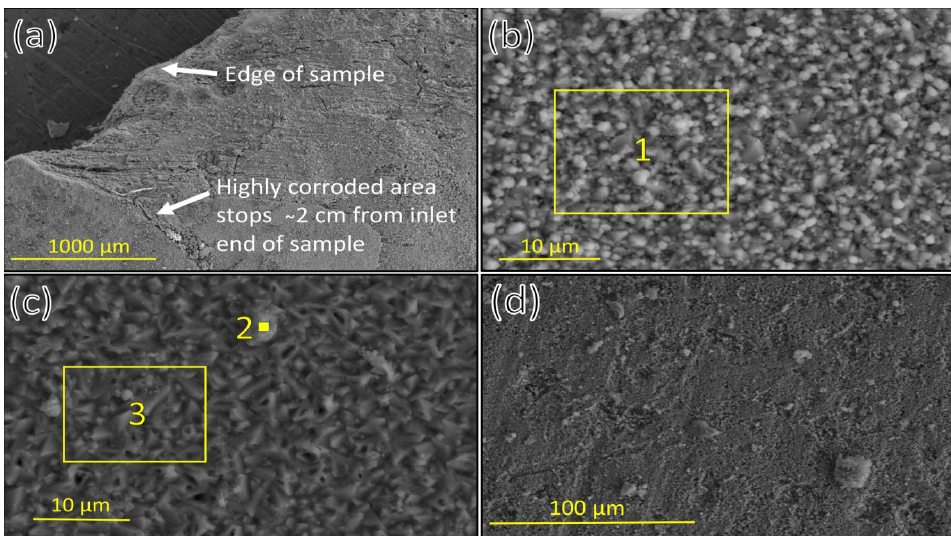
Figure 5. ( a ) Tested carbon-steel sample 1 only one cm from inlet end in the first reactor, ( b ) tested carbon-steel sample 1 now three cm from inlet end in reactor 1, ( c ) tested carbon-steel sample 5 in middle of the second reactor and ( d ) tested carbon-steel sample 9 at the outlet of the last reactor. Table 6. Elemental analysis from locations in Figure 5. Element (wt.%) Location